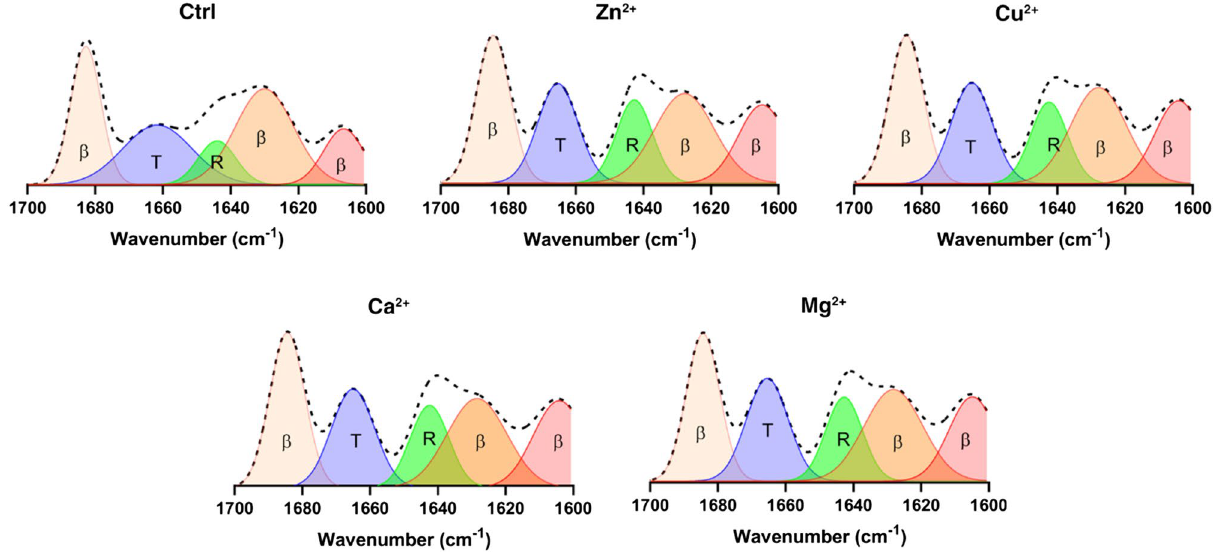
Figure 3. ATR-FTIR spectra and their deconvolution of α-Syn fibrils formed in the presence and absence of each cation. Amide I region (1700–1600 cm −1 ) of each samples’ spectrum are displayed. In each panel the un-deconvoluted spectrum appears as a dashed line, while the deconvoluted spectrum are shown as colorful graphs. The water-subtracted data were base-line corrected, smoothed, and normalized using GraphPad Prism 8. The amide I region (1700–1600 cm −1 ) were fitted based on a Gaussian model using OriginPro 2022. The colorful images were prepared for presentation in the manuscript using GraphPad Prism 8. β: β-sheet; R: random coil; T: β-turn.